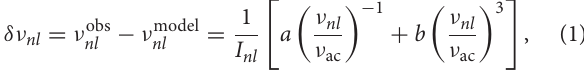
from 1ν , ν max , T eff and metallicity by searching among